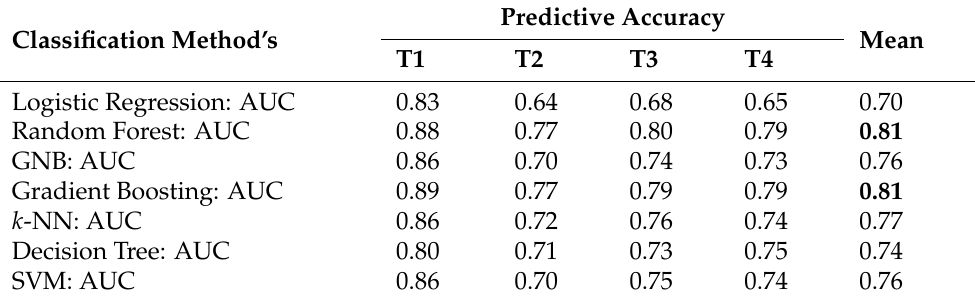
Table 6. Performance, measured with AUC, of different machine learning models when classifying a document as related or unrelated to fraud. T1, T2, T3, and T4, correspond to each data set, where a topic learned from LDA is